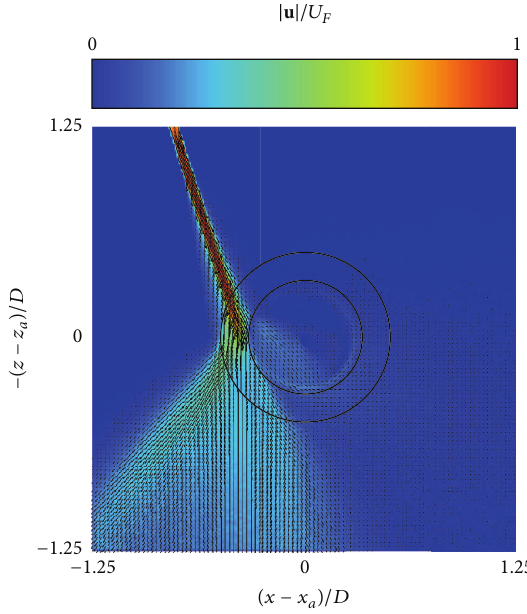
Figure 6: Time-averaged velocity distribution when 𝜆 = 0.56 .